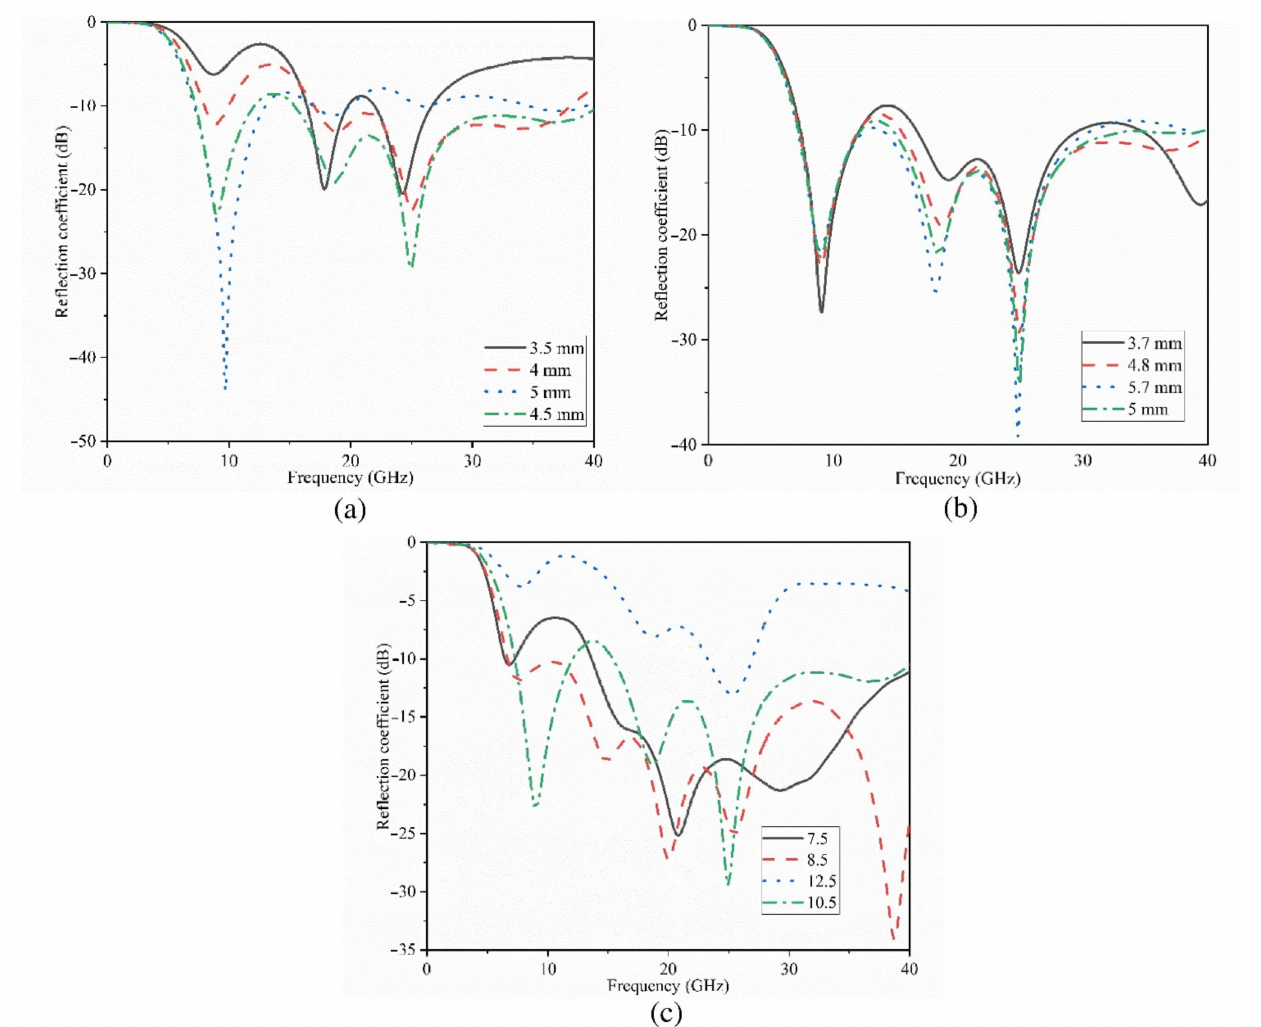
Figure 3. Parametric study of the Ant1: ( a ) feed line (L f1 ), ( b ) ground length (L g1 ), and ( c ) ground width (W g1